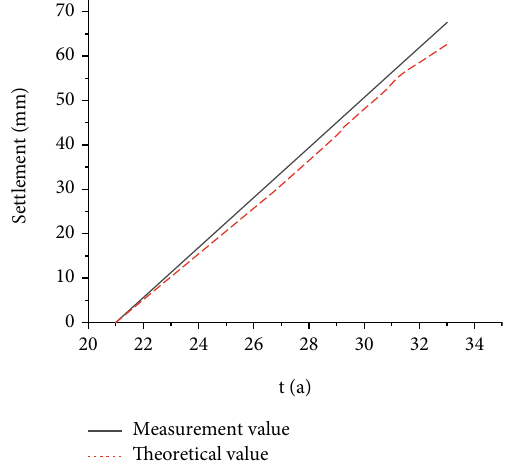
Figure 12: Comparison between the theoretical and measurement values of the settlement of west ventilation